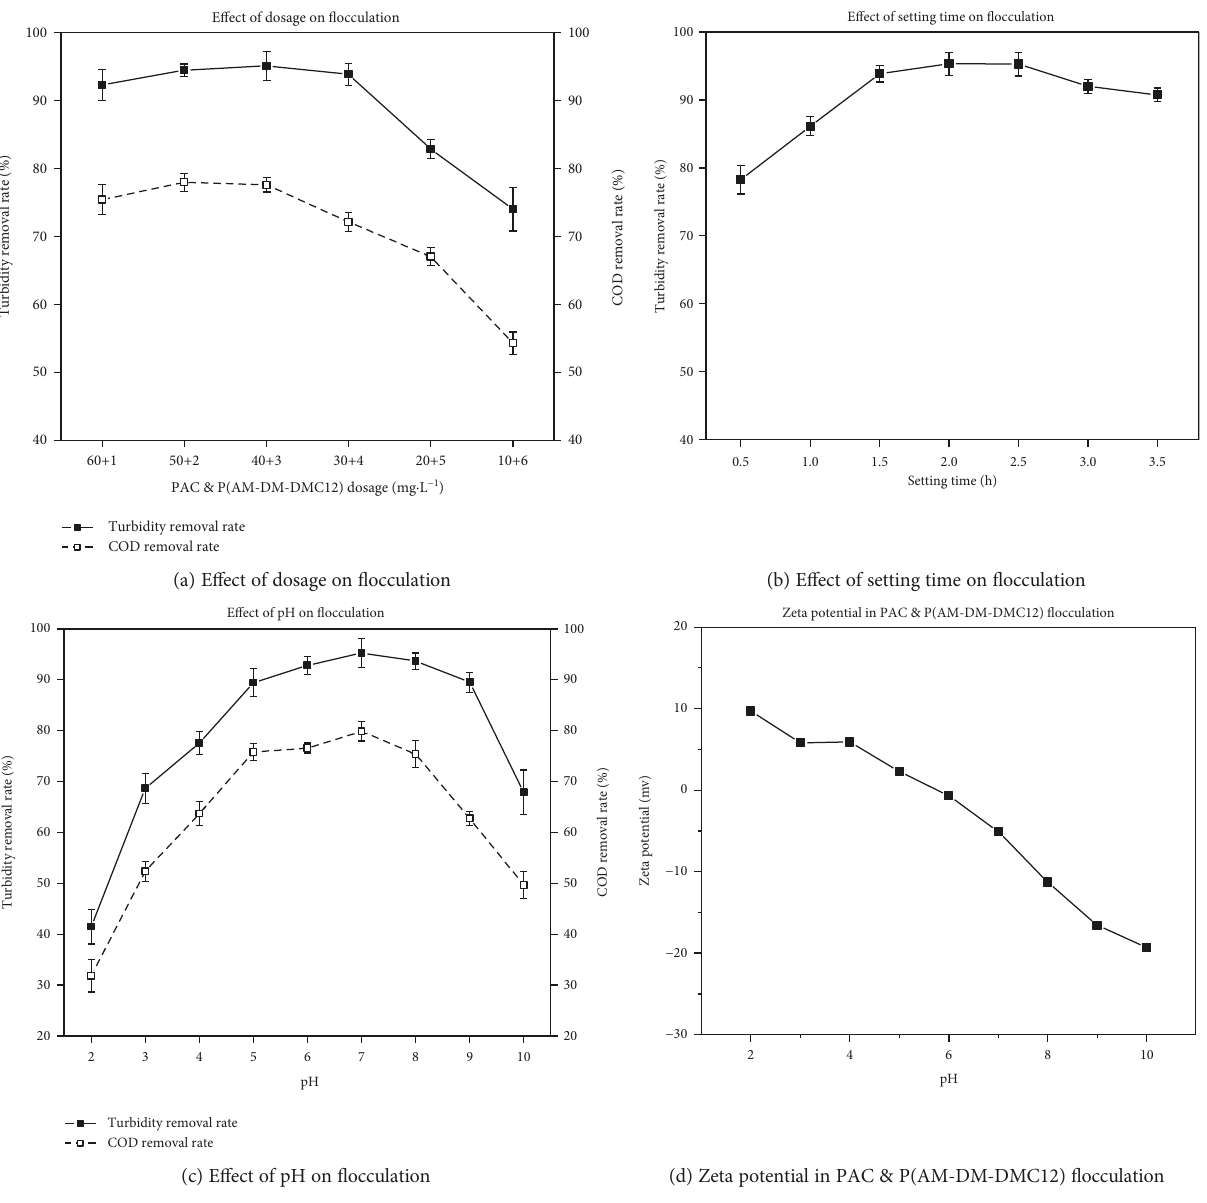
Figure 8: E ff ect of PAC & P(AM-DM-DMC12) on fl occulation